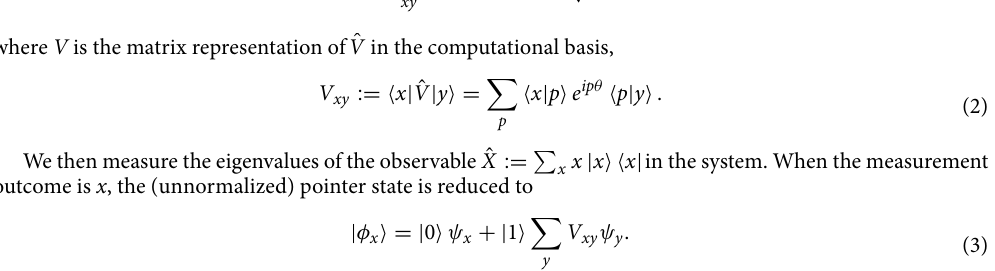
Figure 1. Two equivalent schematics of the single-qubit reaped quantum state tomography. ( a ) The system– pointer interaction is described by the p -dependent conditional phase shift ˆ U p pointer. ( b ) The system–pointer interaction is regarded as the pointer-controlled unitary operator ˆ V the system. The measurement on the system measures the eigenvalues x of the observable ˆ X